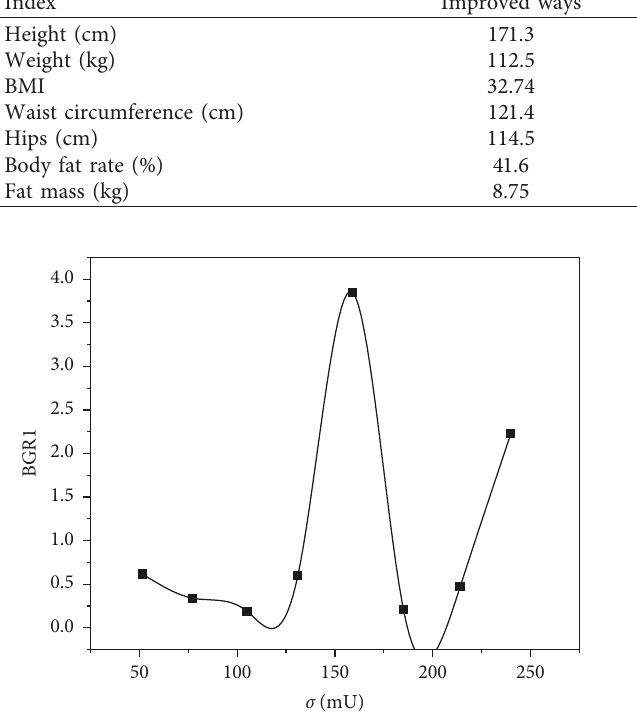
Figure 2: Group A under moderate-intensity aerobic exercise.